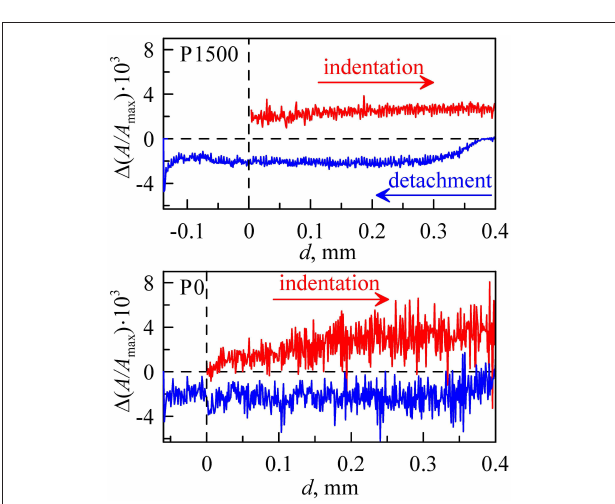
FIGURE 11 | Dependencies of the change in the contact area 1 ( A / A max ) vs. indentation depth d at indentation and detachment of indenter R = 40mm for small (P1500) and big (P0) roughness.